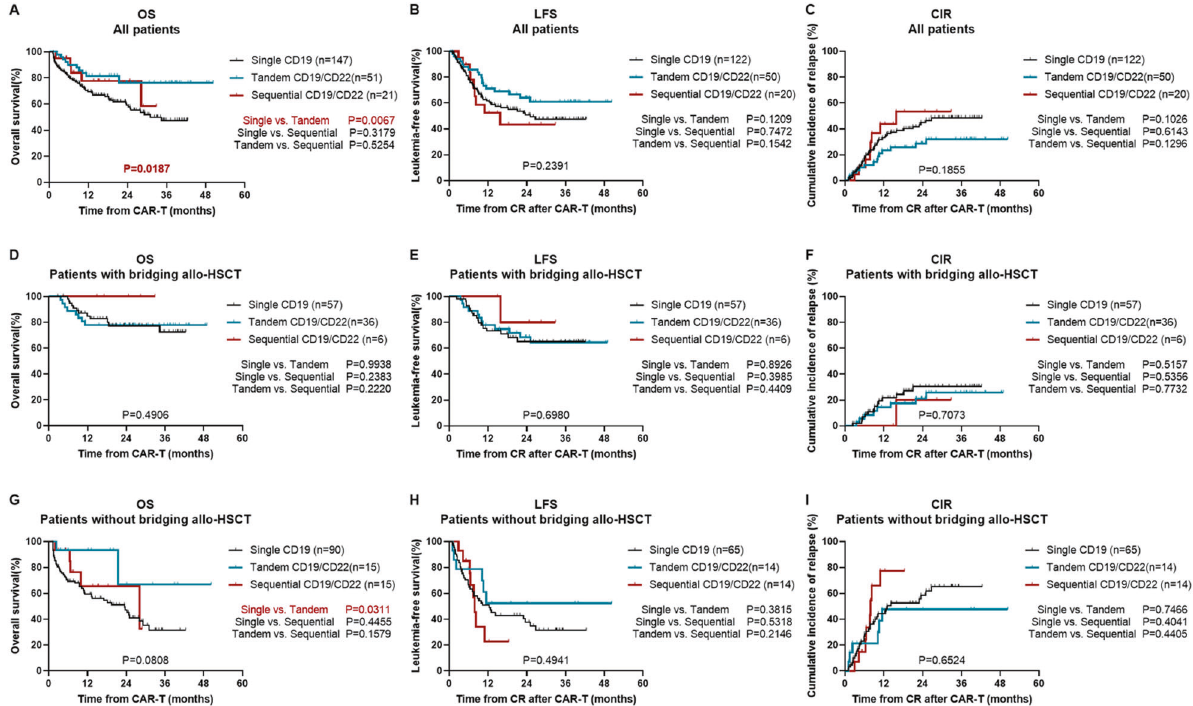
Fig. 3 Survival of patients according to different CAR T-cell therapies. A Overall survival B leukemia-free survival and C cumulative incidence of relapse of patients in the single CD19 group, tandem CD19/CD22 group and sequential CD19/CD22 group. D Overall survival E leukemia-free survival and F cumulative incidence of relapse of patients who underwent allo-HSCT after CAR T-cell therapy among the three groups. G Overall survival H leukemia-free survival and I cumulative incidence of relapse of patients without allo-HSCT after CAR T-cell therapy among the three